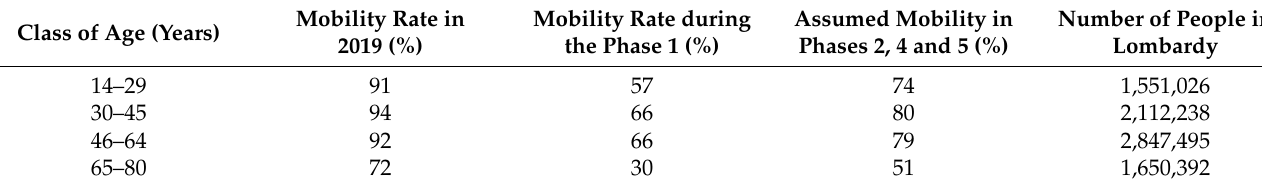
Figure 2. Age classes and sex ratio of the population in the Lombardy region. Table 1. Normal mobility rate for the different age classes in Italy and changes observed during the lockdown phases [41]. People belonging to the different age classes are also reported.